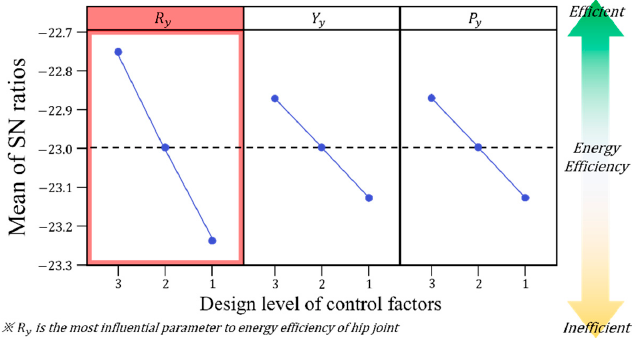
Figure 6. SNRs of three sensitive parameters during the second experiment. The most influential factor is R y , highlighted in red.